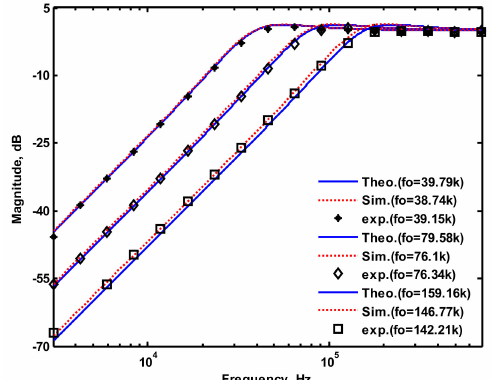
Figure 11. Simulation and experimental results of HP filtering responses at V o3 when V i1 = 0 and V i2 = V in .